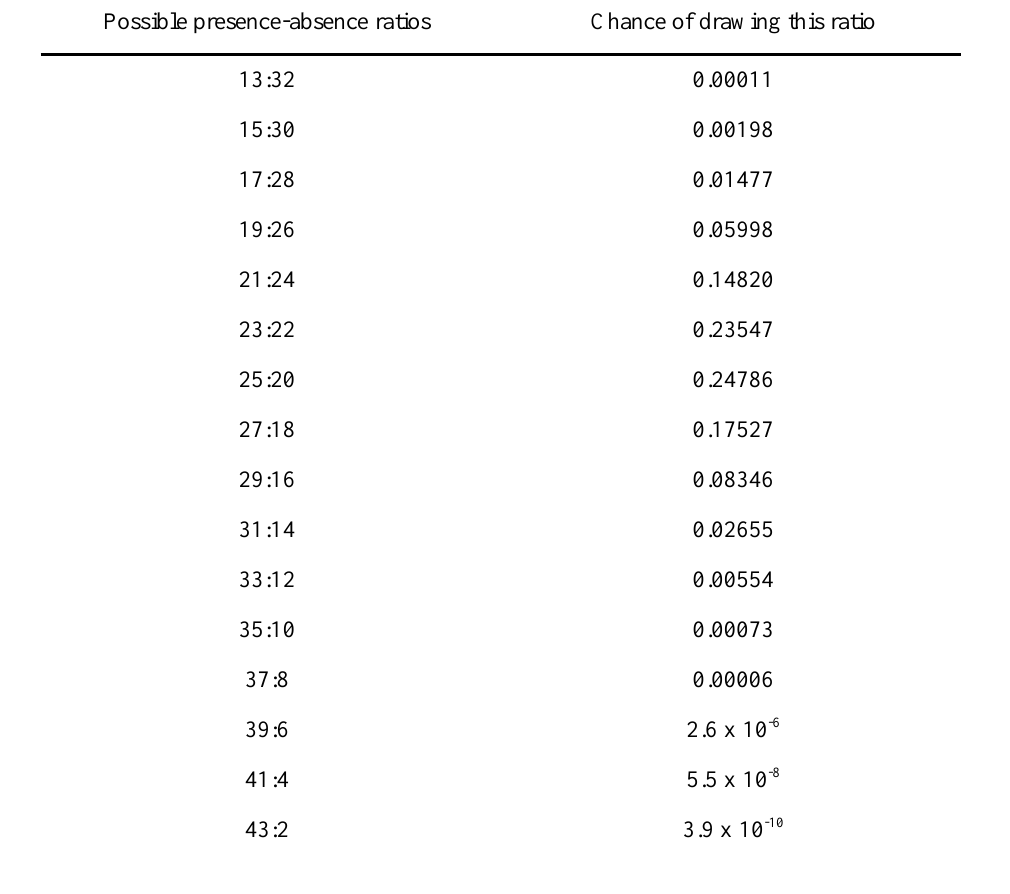
Table 2. Possible presence-absence ratios and their chances of being drawn from an initial case, i.e., historical value, of 30:15 when a 62% repeatability ratio is assumed for re-surveys. Probabilities calculated in Microsoft Excel 2002 using HYPGEOMDIST (((47 – x) / 2),17,30,45) where x ranges from 13 to 43 based on calculations in the